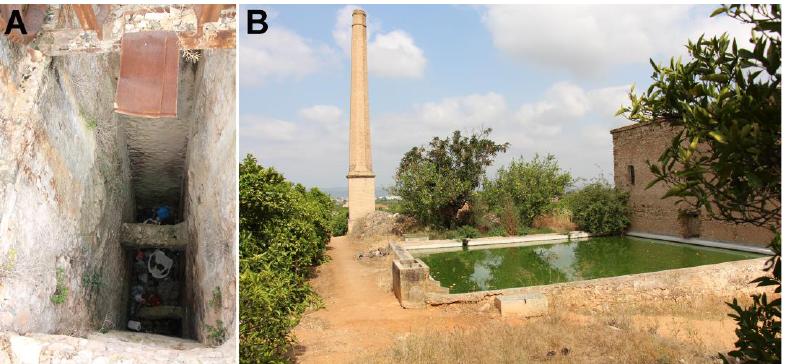
Figure 13. ( A ) Interior of the waterwheel well of the Casa de Boquera in Alzira. ( B ) Waterwheel pond at the Casa de Cogollos in Carcaixent. Source: authors.